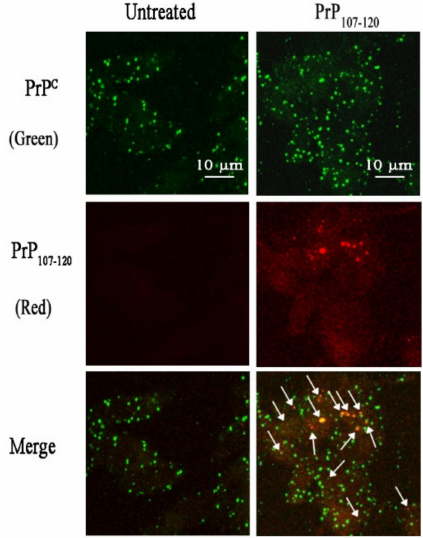
Figure 10. Partial co-localization of PrP 107-120 with endogenous cellular PrP C . Cells were treated for 1 h with the PrP 107–120 sample described in the Figure 9 legend and indicated on top of the images (added to the cell medium). PrP 107–120 was labelled with BODIPY TMR-X NHS Ester (red fluorescence) and cellular PrP C was labelled with mouse monoclonal primary antibody PrP (5B2) and Alexa Fluor 488-conjugated anti-mouse secondary (green fluorescence). The white arrows indicate the co-localization spots in the merged images. Scale bar = 10 µ